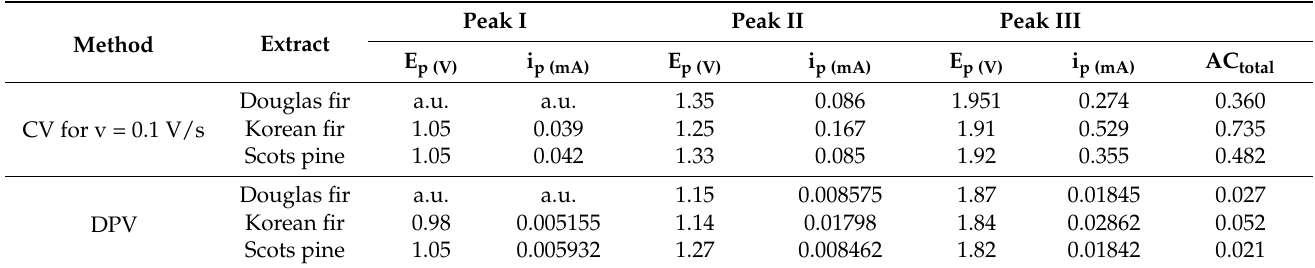
Table 2. E p , i p , AC values for electro-oxidation of compounds contained in extracts tested. Peak I Peak II Peak III Method Extract E p (V) i p (mA) E p (V) i p (mA) E p (V) i p (mA) AC total Douglas fir a.u. CV for v = 0.1 V/s